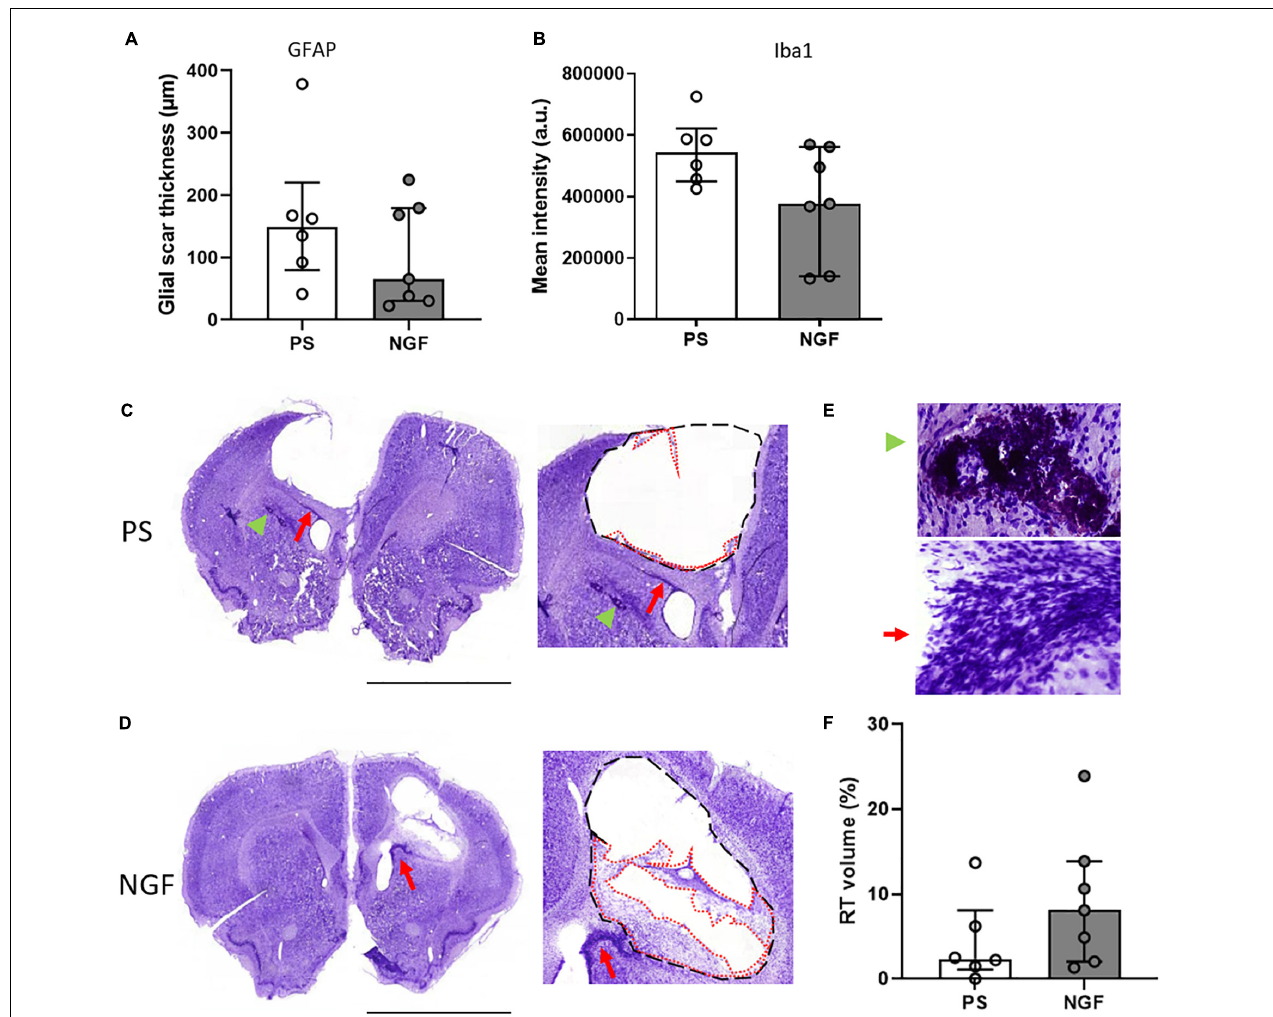
FIGURE 6 | Histology of brain sections and characterization of the lesion: the glial scar and the reconstructed tissue at 12 weeks post-injury. (A) Quantification of the glial scar thickness (expressed in µ m) based on GFAP mean intensity (fluorescence) in PS and NGF groups. There was no significant difference between the groups. (B) Quantification showing the microglia (Iba1 mean intensity) in the glial scar in PS and NGF groups. There was no significant difference between the groups. (C,D) Nissl staining on coronal sections ( left ) and magnifications ( middle ) showing the edges of the lesion (black dashed lines) and the reconstructed tissue (red dotted lines) 12 weeks post-injury in PS (C) and NGF (D) groups. A migration pathway is observed between the ventricle and the lesion edge [Panel (C,D) , Red arrow]. (E) magnifications showing pyknotic tissue (green arrowhead) and migration pathway (red arrow). (F) Graph showing the quantification of the reconstructed tissue (RT) normalized by the lesion volume in PS and NGF groups. All the graphs show the distribution of individual values and the median and the interquartile range. PS group: n = 6; NGF group: n = 7. Scale bars: 5 mm. PS: physiological saline; NGF: nerve growth factor; GFAP: glial fibrillary acidic protein; a.u: arbitrary unit.